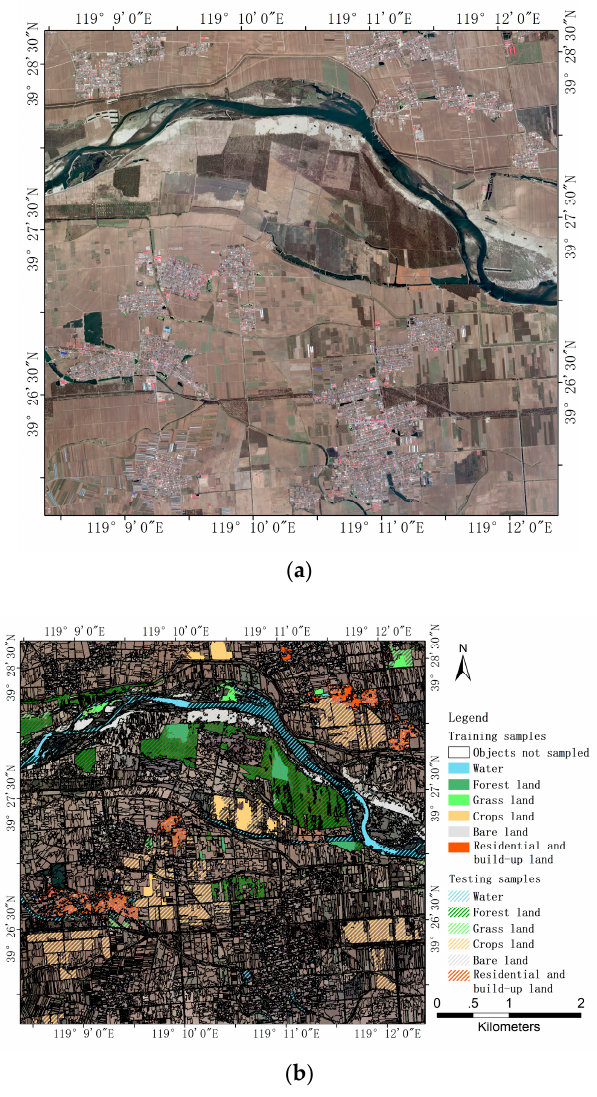
Figure 1. Study area on the eastern coast of China showing the plot acquired by the Gaofen-2 images. ( a ) Geo-referenced and atmospheric corrected image; and ( b ) image overlaying a segmentation layer with training samples and testing samples.